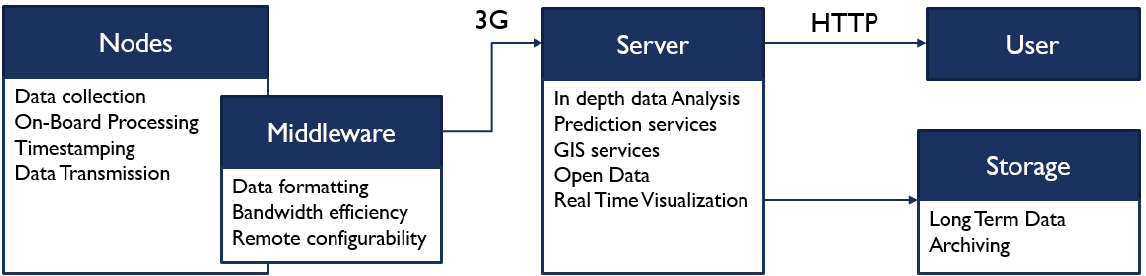
Figure 3. Diagram of the IoT platform’s components and their roles.